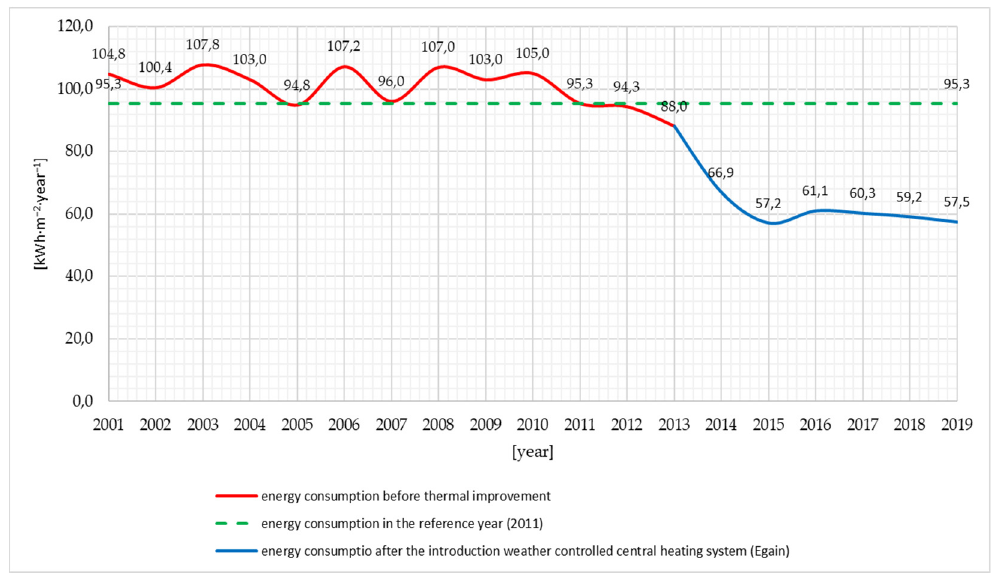
Figure 4. Thermal energy consumption for central heating in the years 2001–2019 in building C.